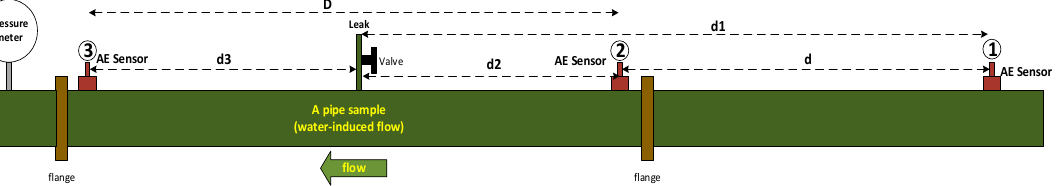
Figure 1. Data acquisition setup.